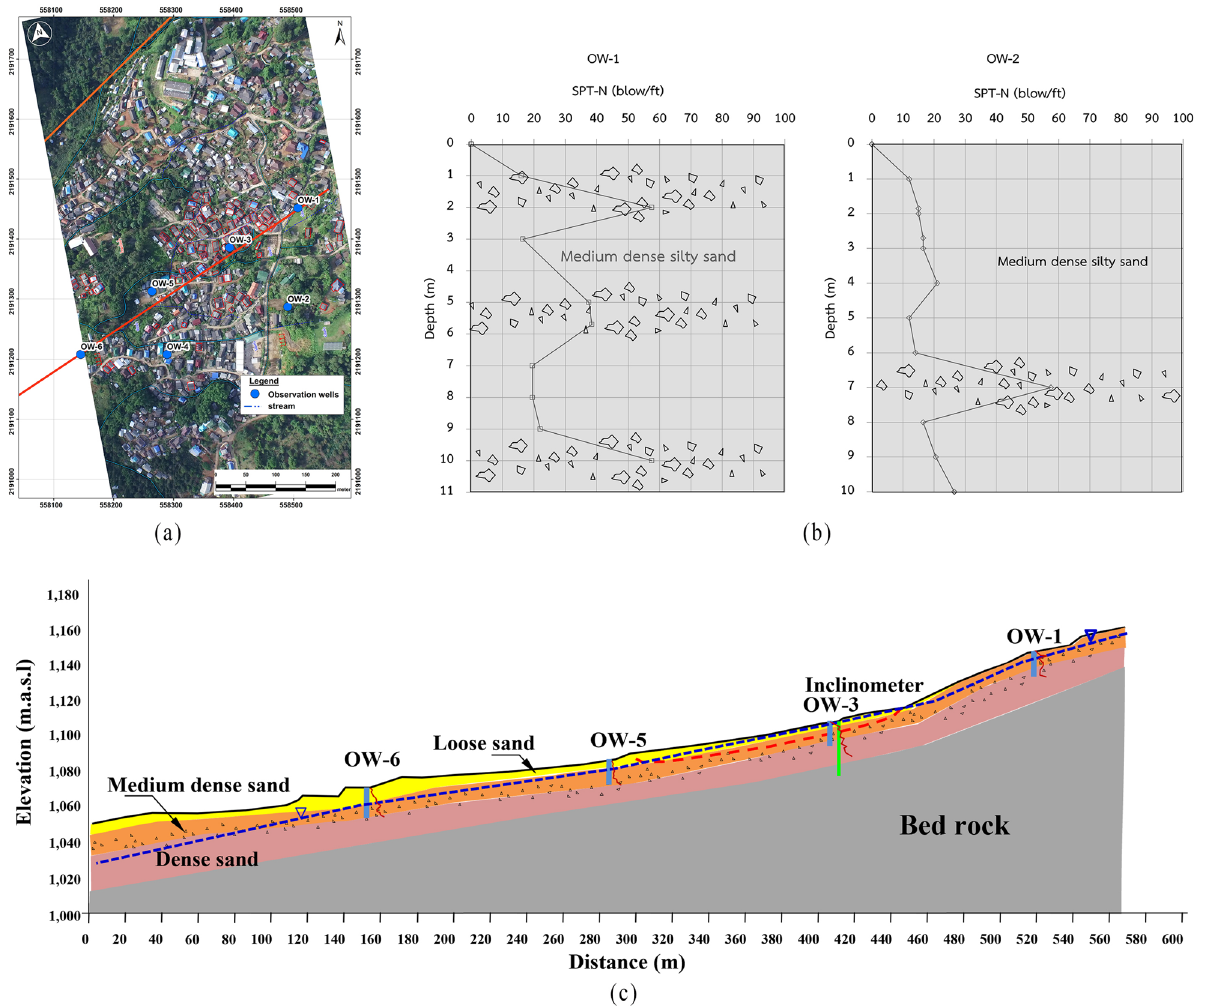
Figure. 7. ( a ) Alignment passing through the damaged section ( b ) Example of SPT test results at OW1 and OW2 demonstrating fragments of boulder ( c ) Transverse section of the lithology of the